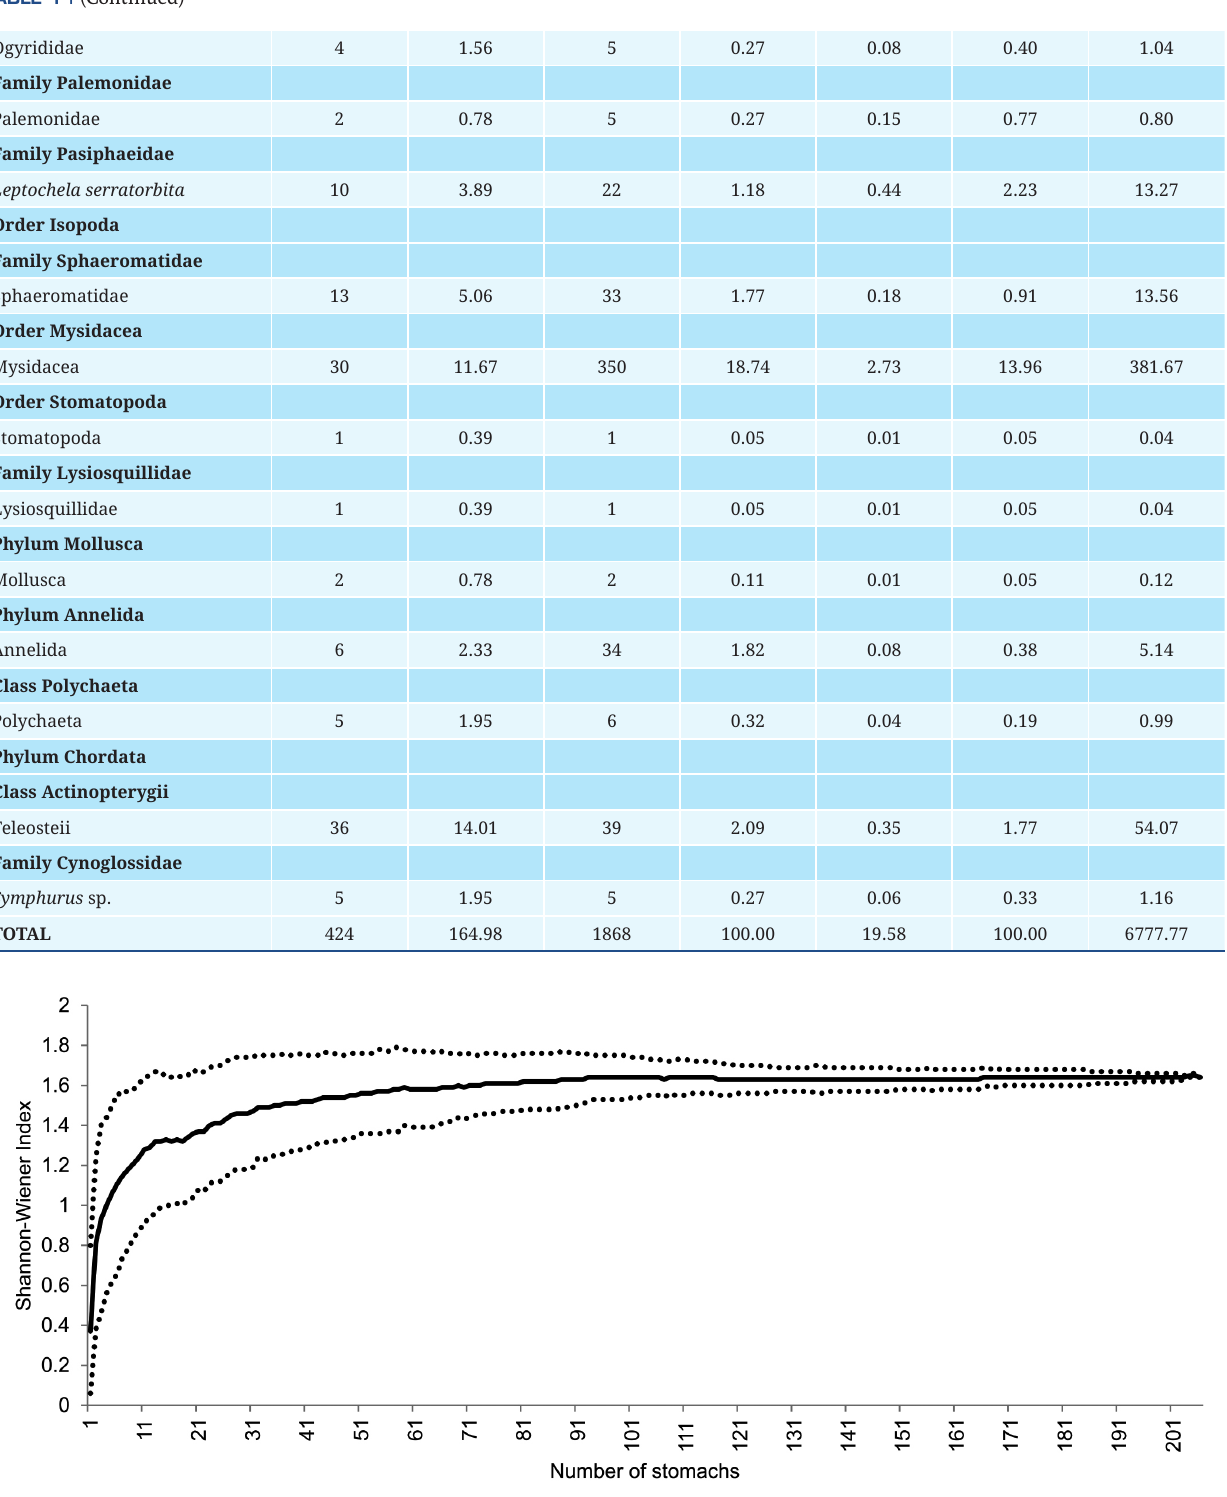
FIGURE 3 | Prey accumulation curve of Urotrygon microphthalmum . Bold line represents mean values of Shannon-Wiener diversity index. Dotted lines represent standard deviation of the